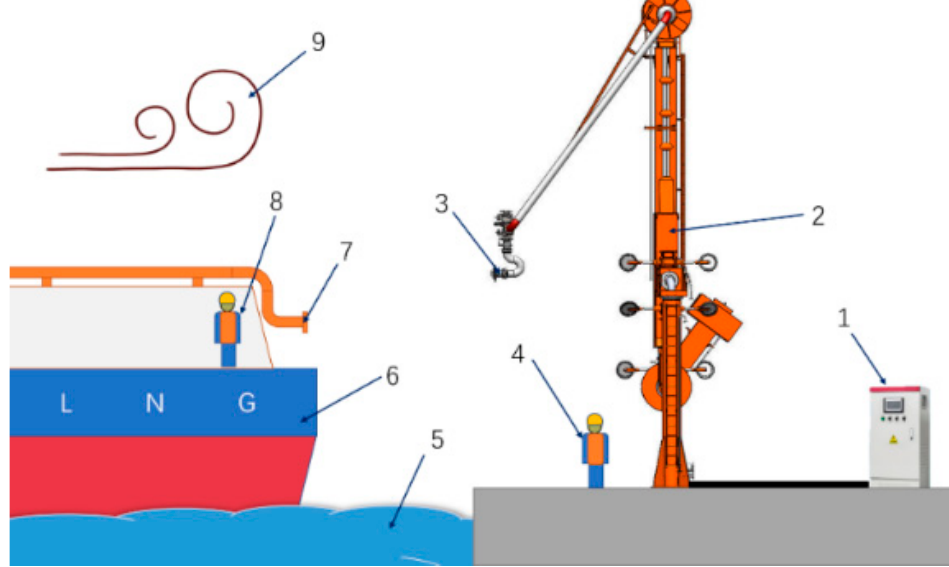
Figure 2. Working schematic diagram of LNG marine loading arm docking with LNG ship. 1—LNG marine loading arm control box; 2—LNG marine loading arm; 3—end joint of the LNG marine loading arm; 4—land operator; 5—wave; 6—LNG ship; 7—transportation pipe interface; 8—ship opera- tor; 9—wind.